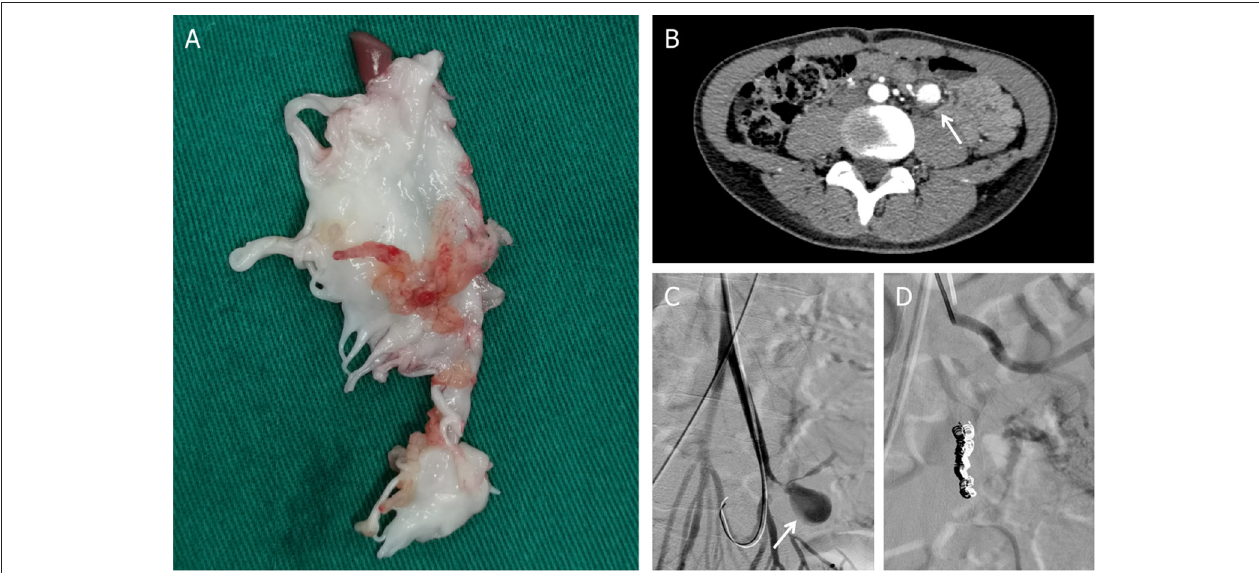
FIGURE 4 | (A) Postoperative mitral valve specimen. (B) Mesenteric arterial branch aneurysms in abdomen CT. (C) Digital subtraction angiography (DSA) indicated pseudoaneurysms (arrow) at the mesenteric arterial branch. (D) Two detachable coils were used to embolize the